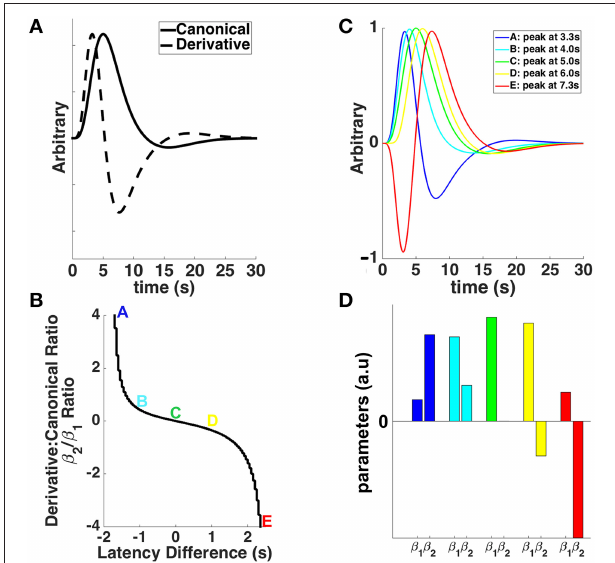
FIGURE 1 | (A) The canonical double-gamma hemodynamic response function (HRF—solid line) and its first temporal derivative (dashed line) plotted against post-stimulus time. (B) The relationship between the ratios of derivative and canonical HRF parameter estimates ( β 2 / β 1 ) and the latency difference from the canonical HRF’s time to peak (i.e., 5s). Colored letters match with the different shapes of the HRFs shifted (or not) in time in (C) , and the canonical ( β 1 ) and derivative ( β 2 ) parameter estimates in (D) . (C) The canonical HRF (green), peaking at 5s, together with HRFs shifted earlier (cyan and blue) and later (yellow and red) in time. (D) Parameter estimates for canonical HRF ( β 1 ) and temporal derivative ( β 2 ) associated with different shapes of the HRFs shifted (or not) in time in (C)